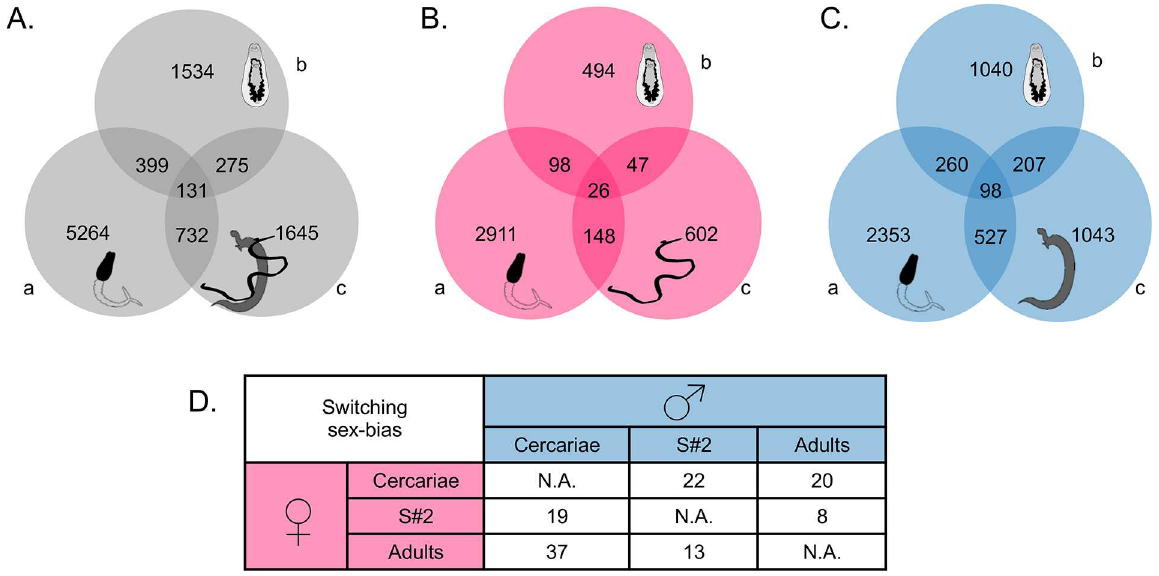
Fig 2. Venn diagrams of sex-biased genes. For each of the three developmental stages (a) cercariae, (b) schistosomula s#2 and (c) adults, significant differences (Padj < 0.05) between sexes were detected by DEseq analyses. Here are represented the number of sex-biased genes by stage and those that are shared between different stages: (A) when poolingmale- and female-biased genes, or considering only (B) female-biased genes or (C) male-biasedgenes. (D) The table representsthe number of sex-switching biased genes that are more expressed alternatively in females or in males dependingon the developmental